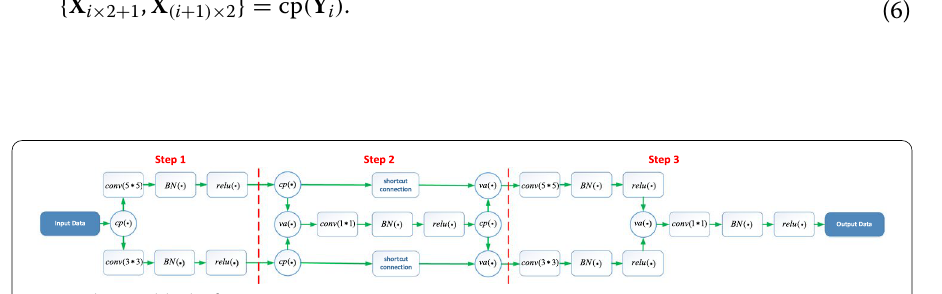
Fig. 3 The unit block of